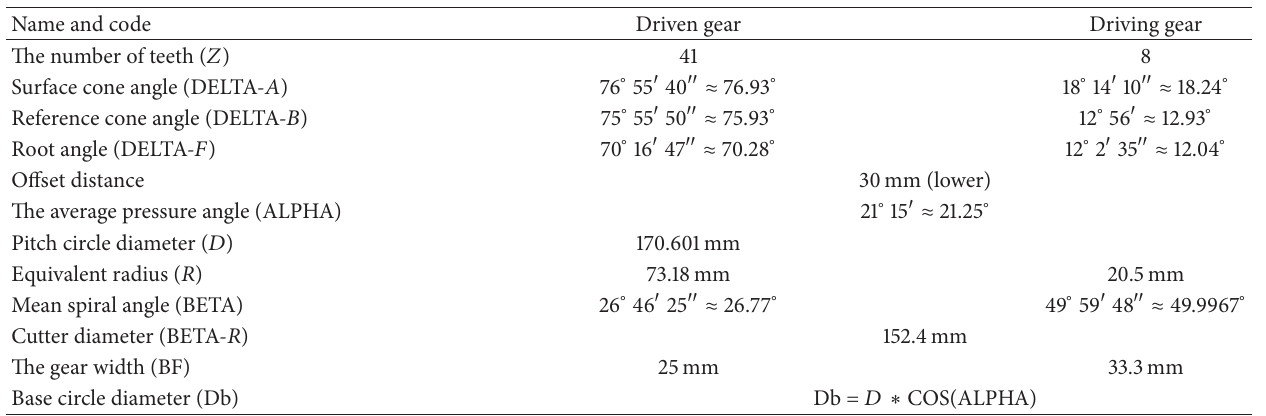
Table 2: Main parameters of gears.